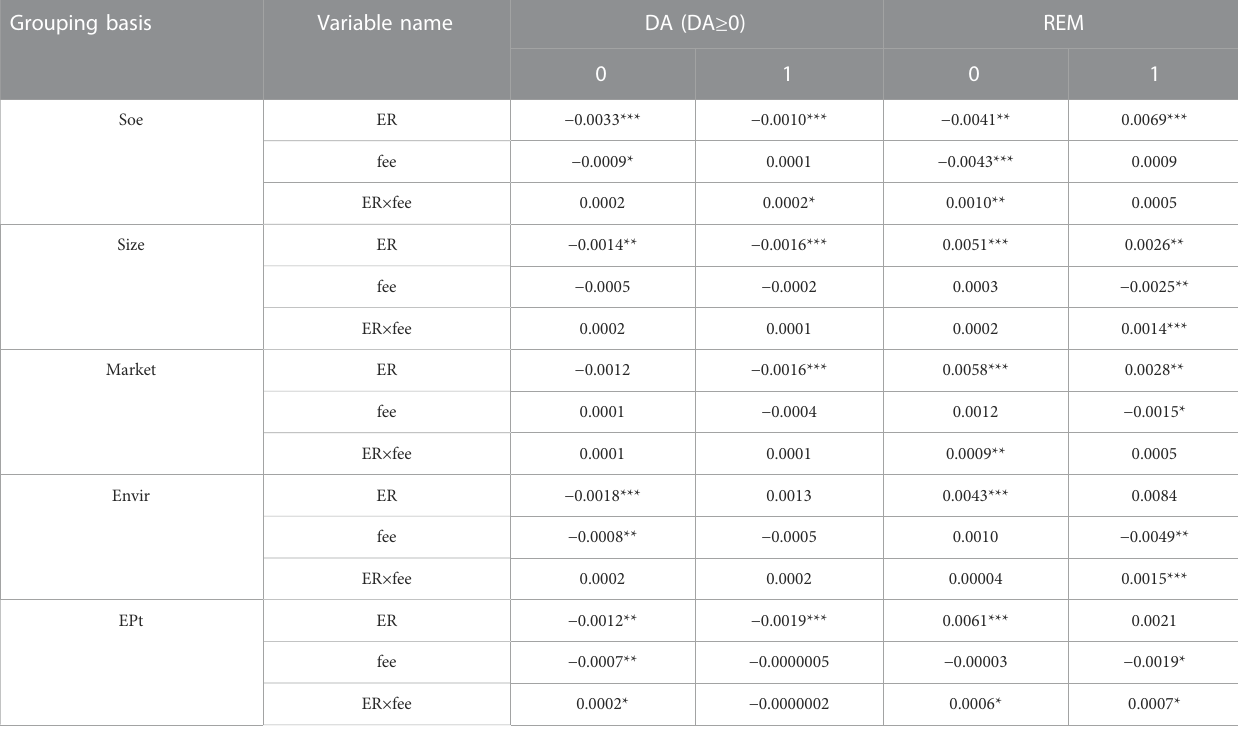
TABLE 7 Results of group analysis. Grouping